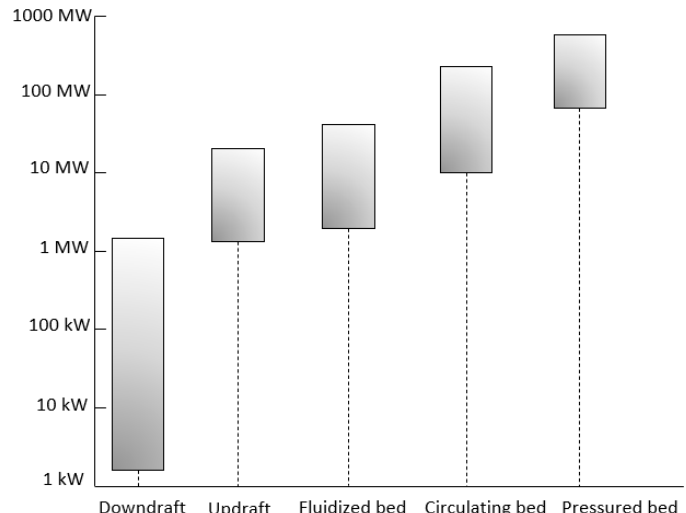
Figure 4. Types of gasifier according to their output power. Table 3. Gas quality requirements for internal combustion engines [29,30].